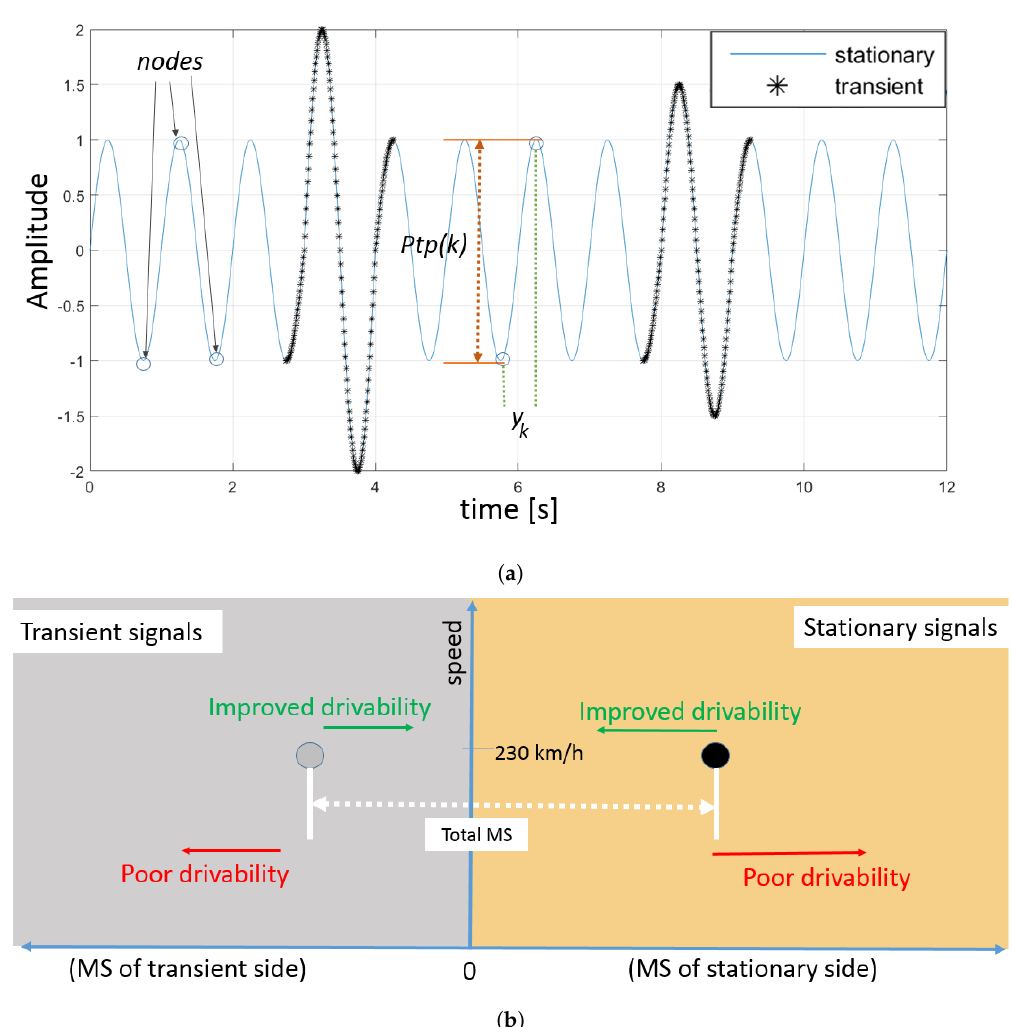
Figure 5. Differentiation of Stationary-Transient Signal [24]: ( a ) A signal divided into segments, where Peak-to-Peak distance is marked and the dotted line segments are sorted as transient. ( b ) Simple representation of how to read the ride diagrams. Left side represents Mean Squared Value (MS) of transient part and right side represents Mean Squared Value (MS) of stationary